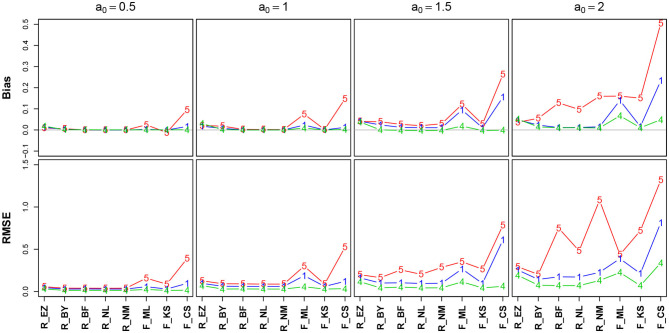
Bias (upper row) and RMSE (lower row) of the boundary separation parameter a. red line/symbol “5”: 50 trials; blue line/symbol “1”: 100 trials; green line/symbol “4”: 400 trials; for abbreviations see Figure 3.